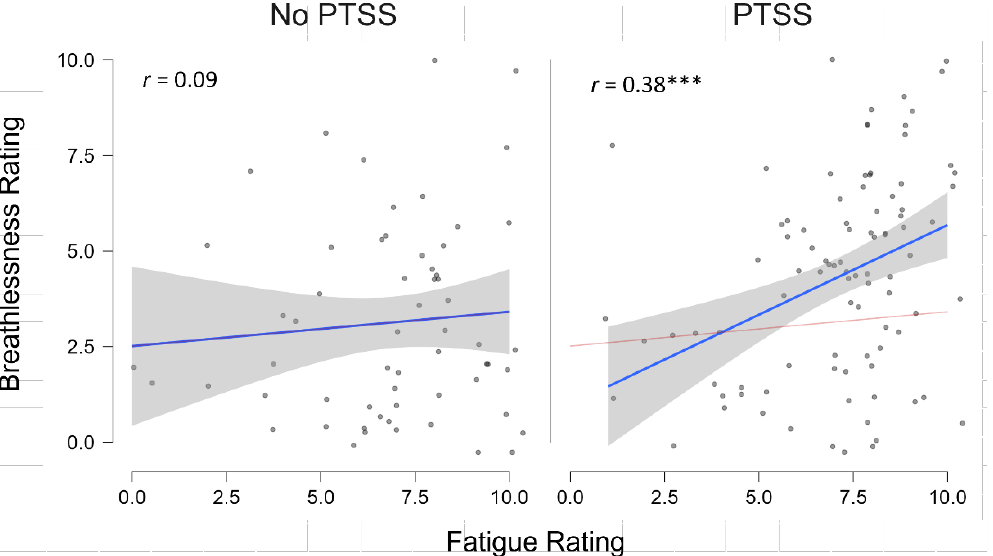
Figure 1. Correlations between fatigue and breathlessness in Post COVID-19 Syndrome (PCS) displayed separately by Post Traumtic Stress Symptoms (PTSS) group. *** p < 0.001.